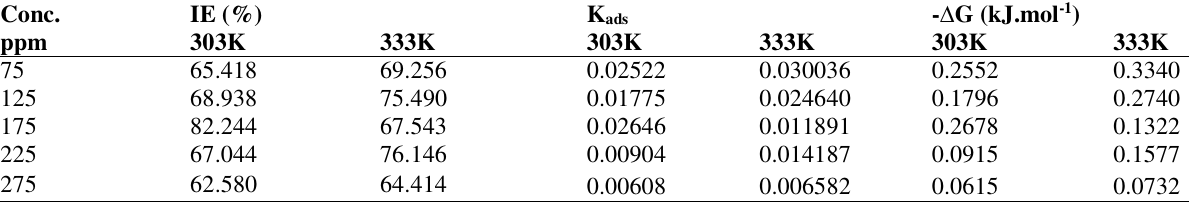
Calculated data of polarization behavior for inhibition.